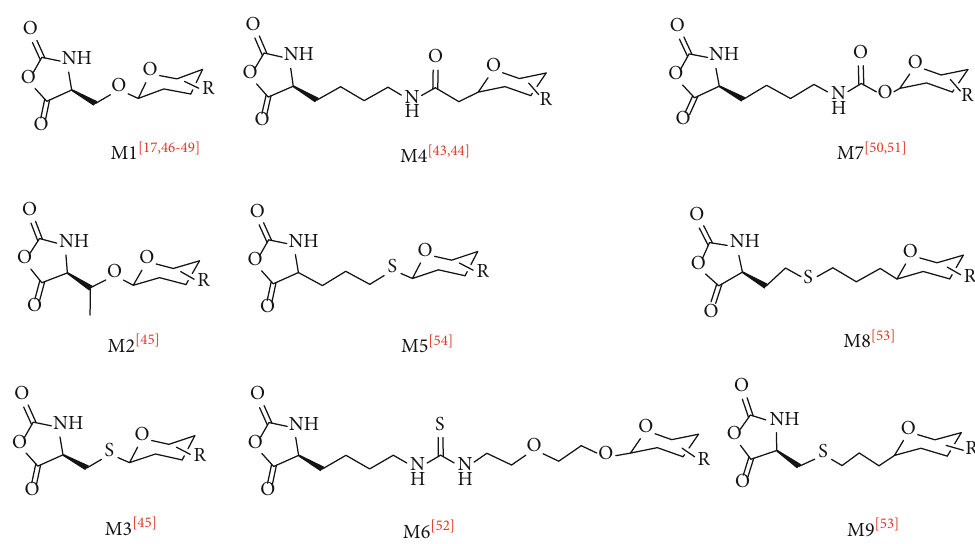
Scheme 4: Chemical structures of sugar-substituted NCA